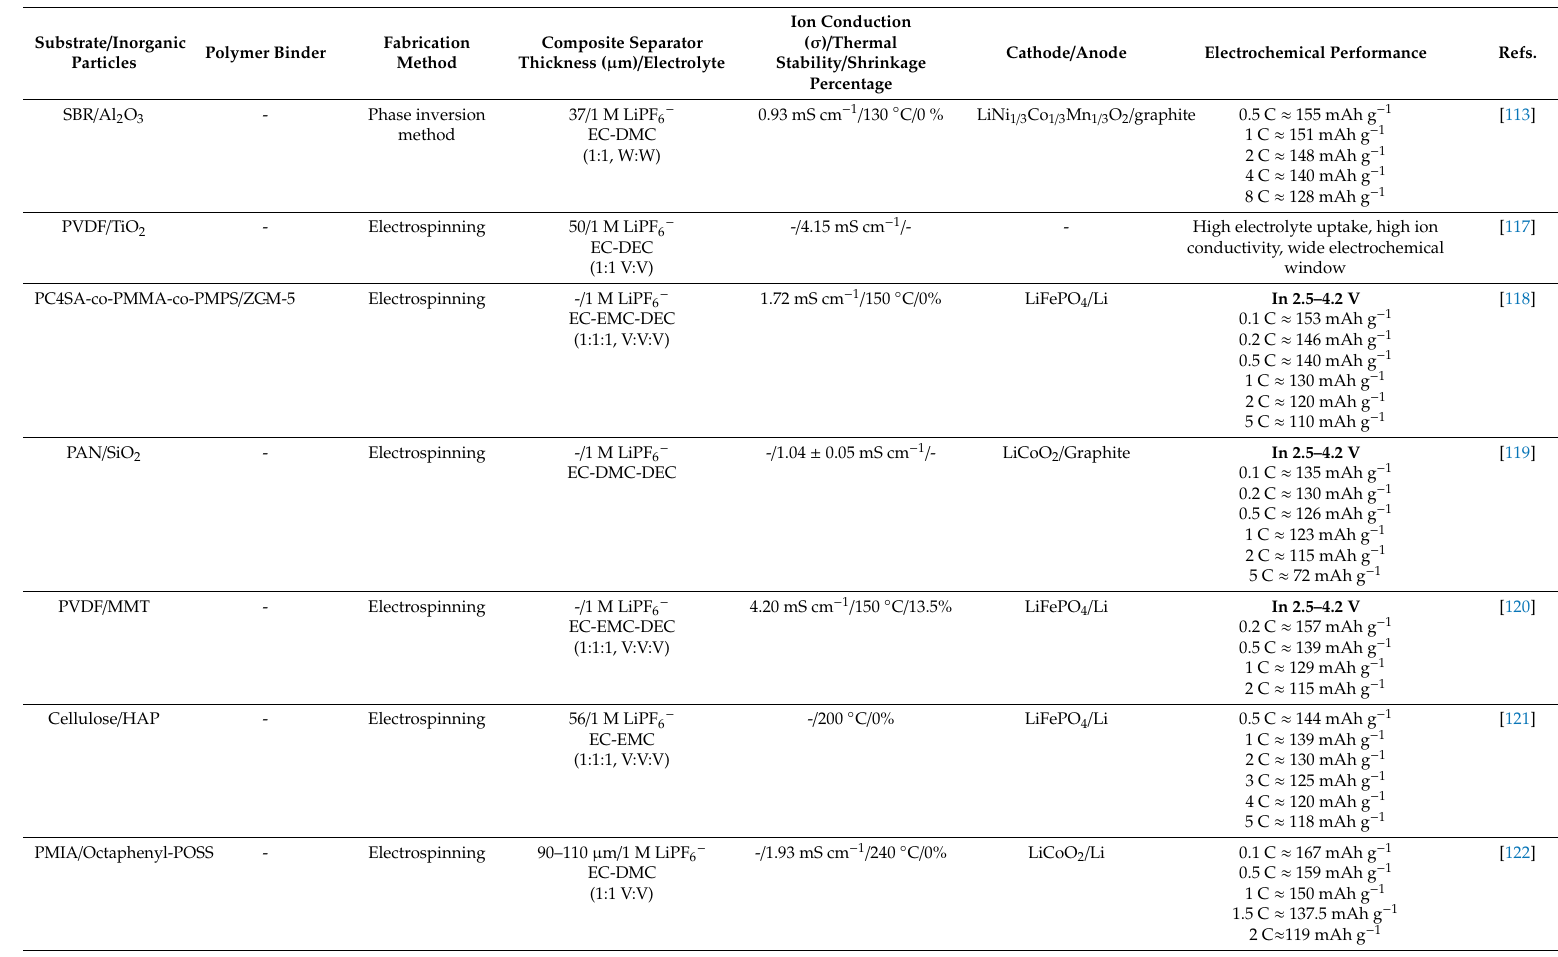
Cathode / Anode Electrochemical Performance